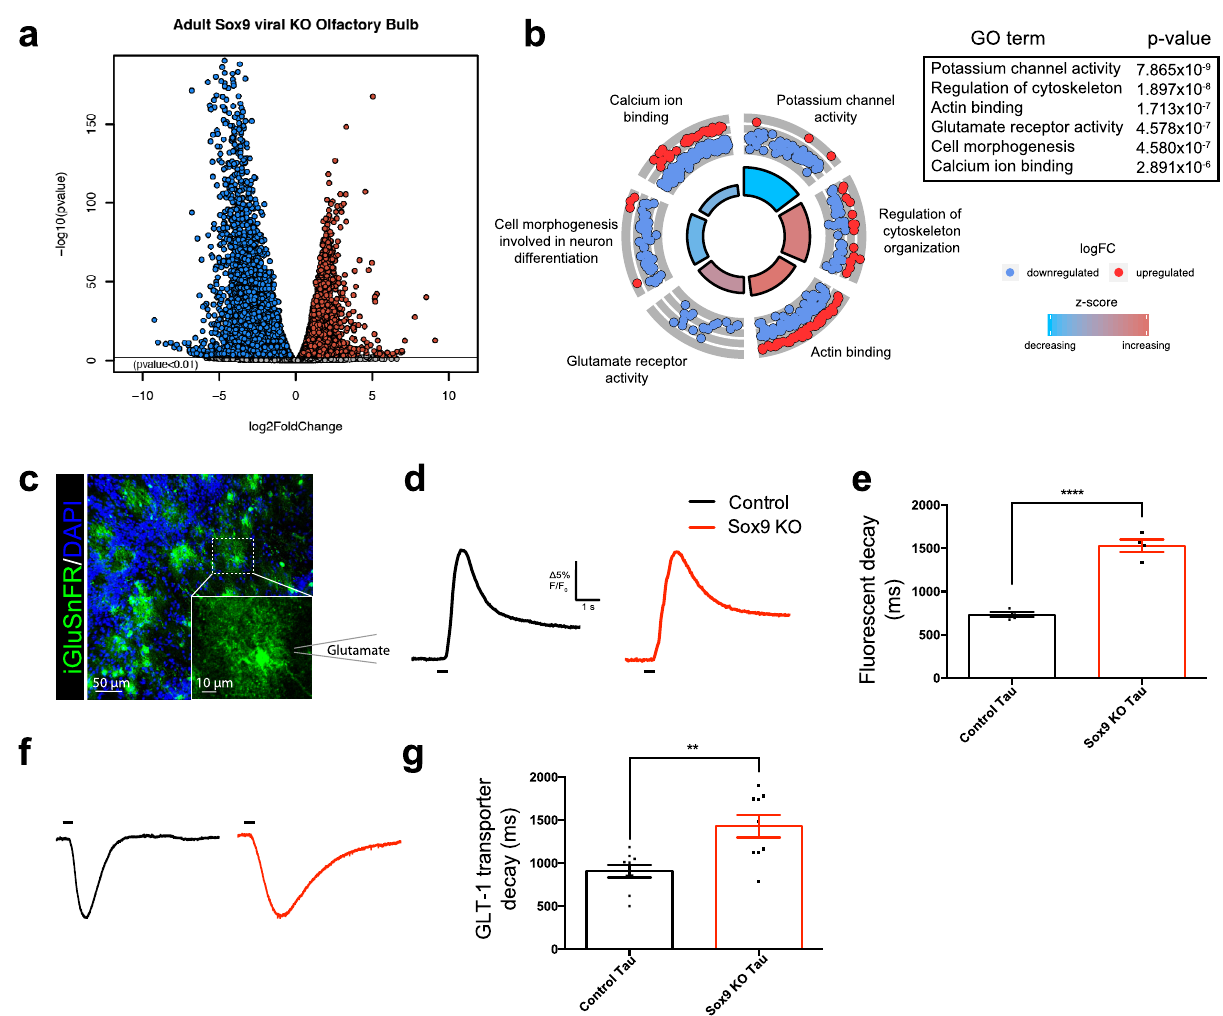
Fig. 5 RNAseq revealed a signi fi cant change in transcription pro fi le of adult, Sox9-deleted astrocytes. a Volcano plot of genes signi fi cantly upregulated (red dots) and downregulated (blue dots) in Sox9 -deleted astrocytes compared to controls. b Downregulated genes from Sox9 deletion revealed GO terms associated with neurotransmitter receptor and ion channel activity, as well as cellular morphology. c Representative high resolution image of iGluSnFR expressed in astrocytes in the OB. N = 4 mice. Inset: high magni fi cation of a single astrocyte with schematic of glutamate puffer nearby astrocyte. d Example trace of iGluSnFR signal from control and Sox9 KO astrocytes after puf fi ng glutamate [534 mM]. Black line indicates duration of glutamate puff. e Quanti fi cation of ( d ). Sox9 KO astrocytes had a signi fi cantly increased decay after puf fi ng glutamate. n = 37 cells (control) and n = 35 cells ( Sox9 KO) from N = 4 mice, respectively. **** p < 0.0001. Two-tailed Student ’ s t-test. Data are presented as mean values ± SEM. f Example peak normalized traces from whole cell electrophysiological recordings of glutamate transporter currents in astrocytes. Black line indicates duration of glutamate puff. g Quanti fi cation of ( f ). Sox9 KO astrocytes had a signi fi cantly increased decay after puf fi ng glutamate. n = 9 cells (control) and n = 9 cells ( Sox9 KO) cells from N = 4 and 3 mice, respectively. ** p = 0.0032. Two-tailed Student ’ s t-test. Controls in A-B and F-G are C57BL/6 J injected with AAV-GFAP-iCre-P2a- TurboRFP; controls in C-E are C57BL/6 J injected with AAV-GFAP-iGluSnFR. Data are presented as mean values ±